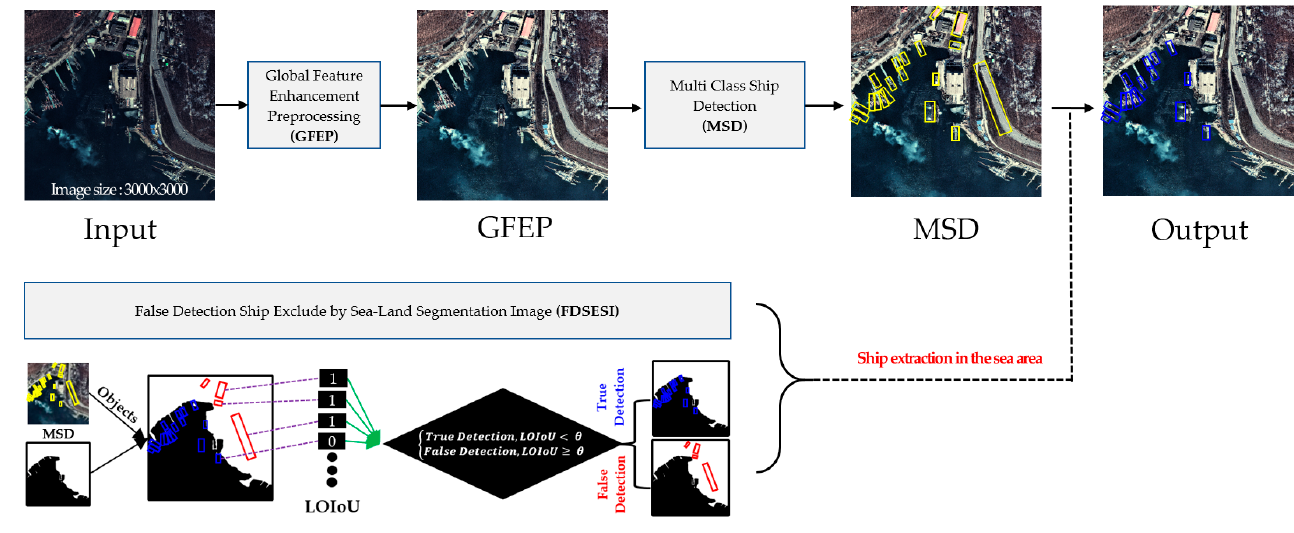
Figure 1. Schematic of proposed methodology.